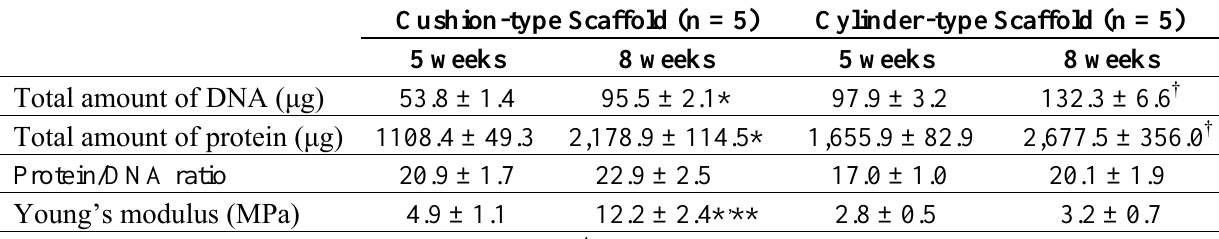
Table 5. Biochemical and biomechanical evaluations of engineered cartilage in both scaffold materials [18].